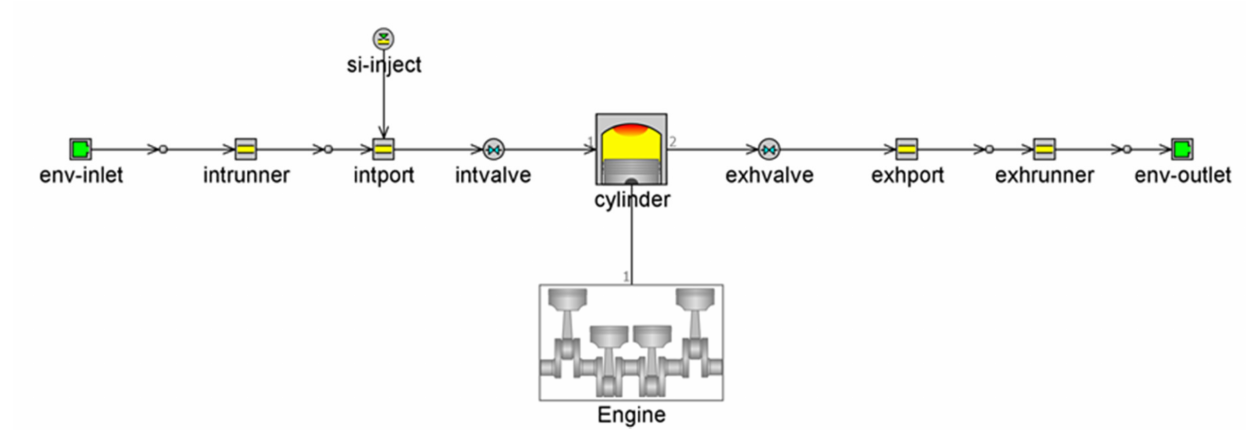
Figure 1. One-dimensional (1D) CFD model of single spark ignition